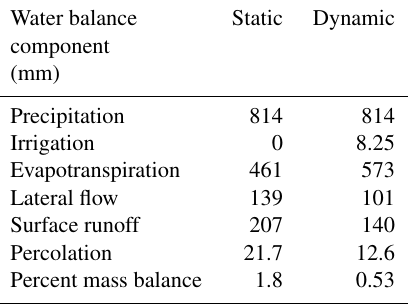
Table 3. Comparison of water balance component for the basin